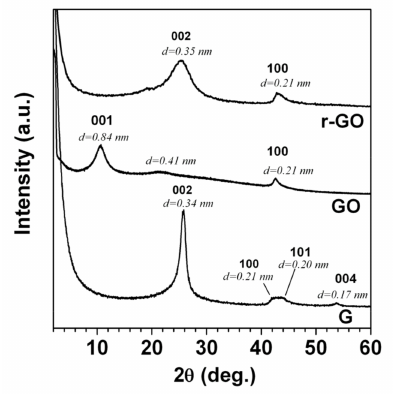
Figure 1. X-ray di ff raction patterns of graphite (G), the resultant graphene oxide (GO) obtained by the Hummers’ method, and the final reduced graphene oxide (r-GO) obtained by solvothermal